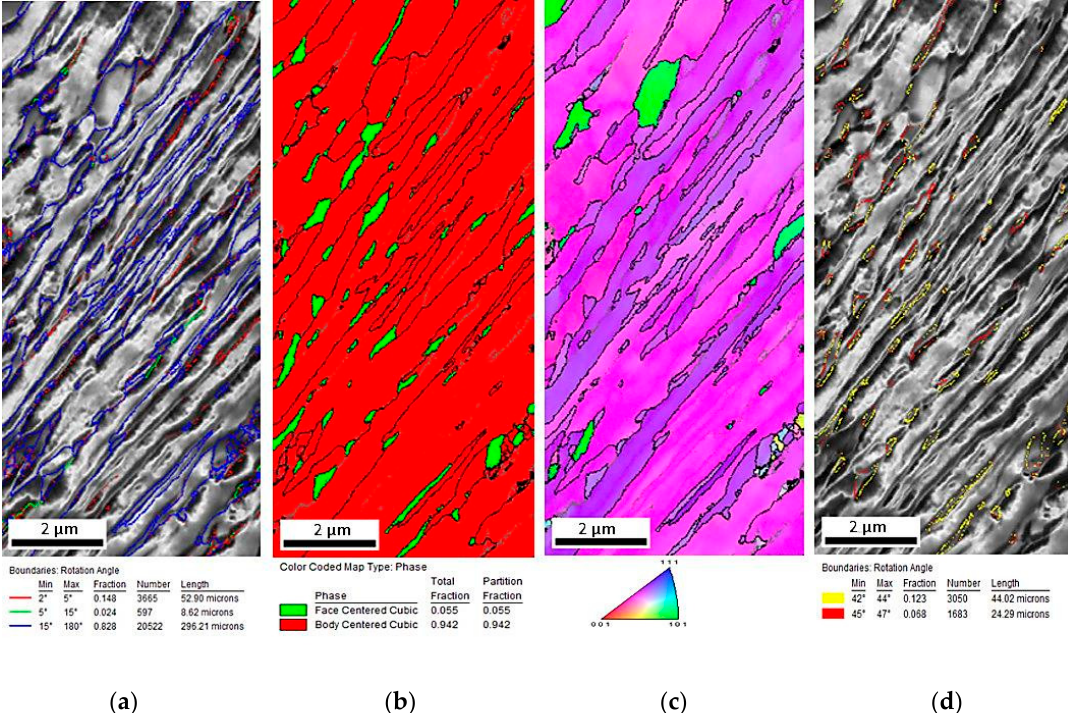
Figure 2. Electron backscatter diffraction (EBSD) analyses of the steel in the initial state. Image quality (IQ) map ( a ), phase distribution map—retained austenite (RA) as green ( b ), orientation map ( c ), map displaying the boundary character between γ and α grains ( d ). Table 1. Morphological parameters of retained austenite at di ff erent deformation temperatures determined using the EBSD